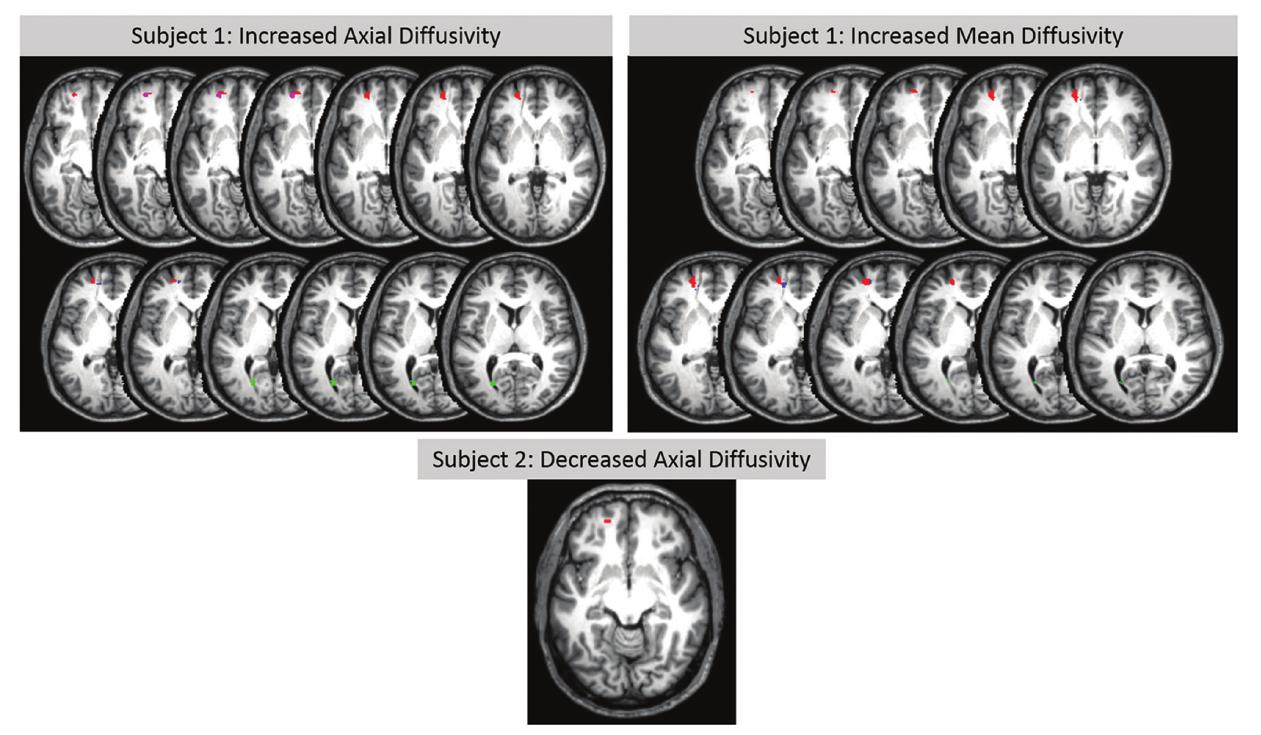
FIGURE 3 | T 1 -weighted axial MRI images of DTI-based analysis in subjects 1 and 2. Increases in AD (left top images) and in MD (right top images) are shown in subject 1 in the left superior frontal gyrus (red), left middle frontal gyrus (magenta), left anterior cingulate gyrus (blue), and left posterior cingulate gyrus (green). A decrease in AD (medial bottom image) is shown in subject 2 in the left superior frontal gyrus (red; decreased MA in the same ROI is not shown). Significant changes (small volume correction, p < 0.05 corrected) are relative to a healthy control